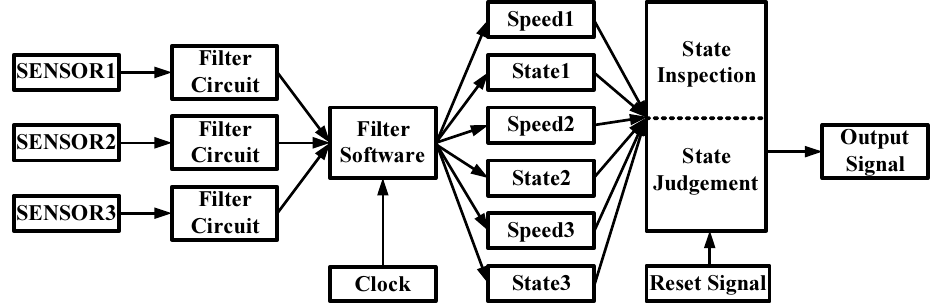
Figure 14. The control logic of the OPC2 module.